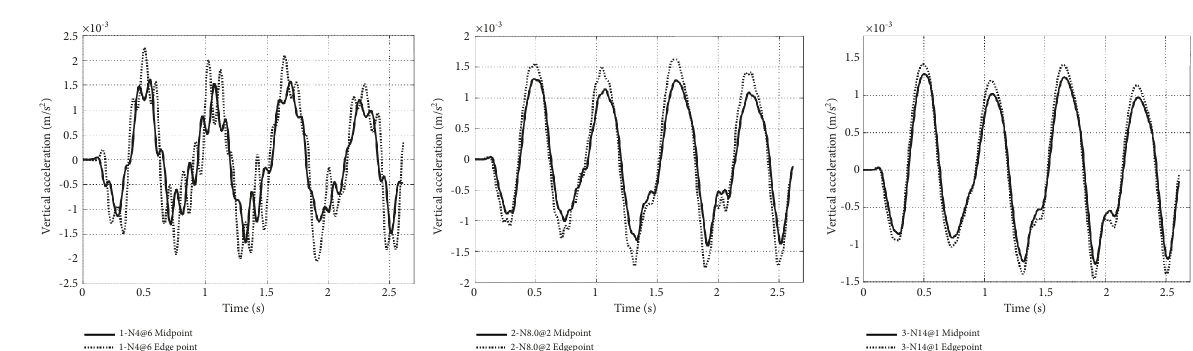
Figure 13: Vertical acceleration response of different pickup points when the number of isolators